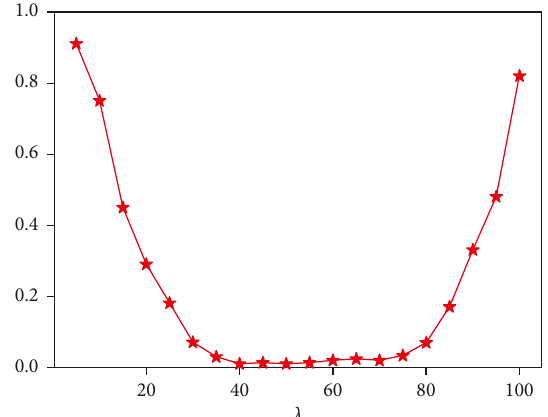
Figure 3: FBD detection rate under different λ